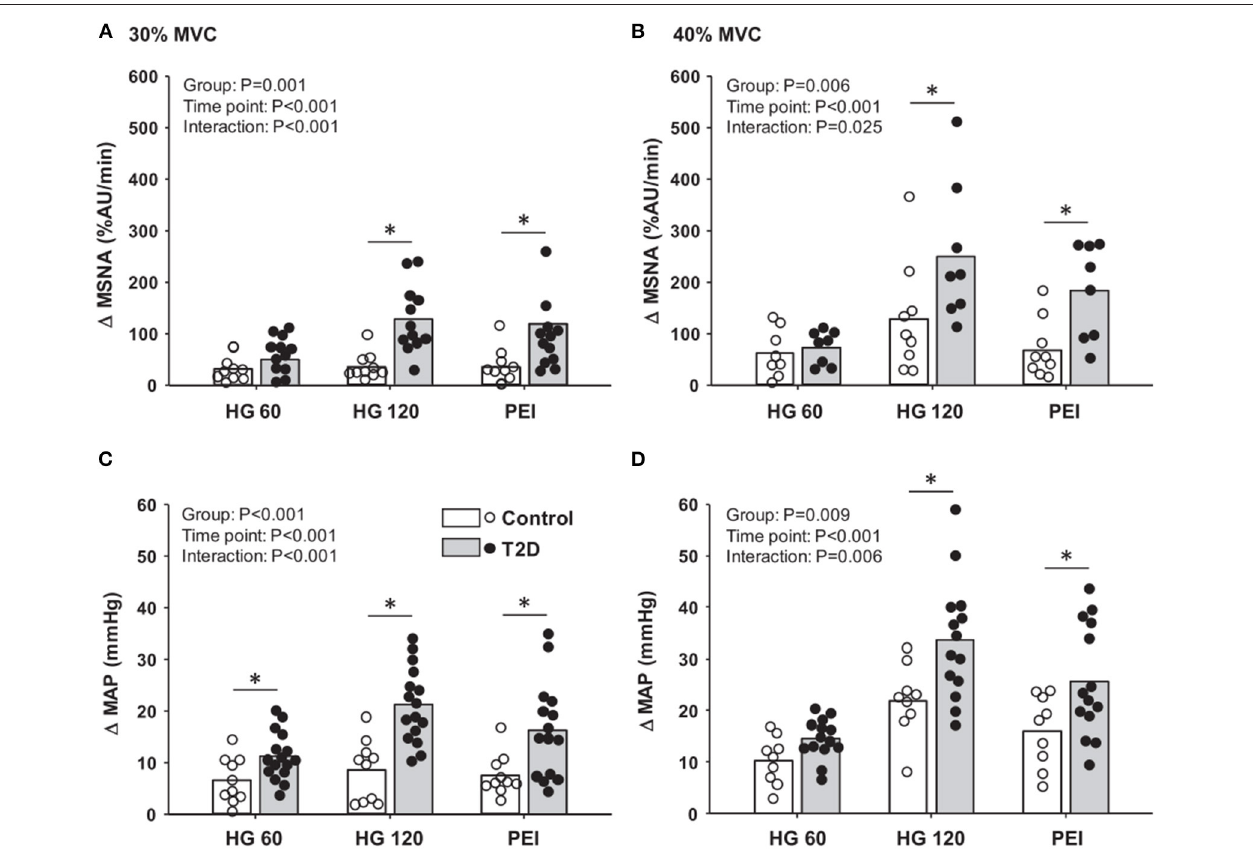
FIGURE 1 | Mean data and individual data showing changes in muscle sympathetic nerve activity (MSNA; A,B ) and mean arterial pressure (MAP; C,D ) at 60 and 120s of 30 and 40% maximal voluntary contraction (MVC) handgrip followed by subsequent periods of post-exercise ischemia (PEI) in type 2 diabetes (T2D) patients and control subjects. * P < 0.05 vs. control. Modified from Holwerda et al. (2016a) with